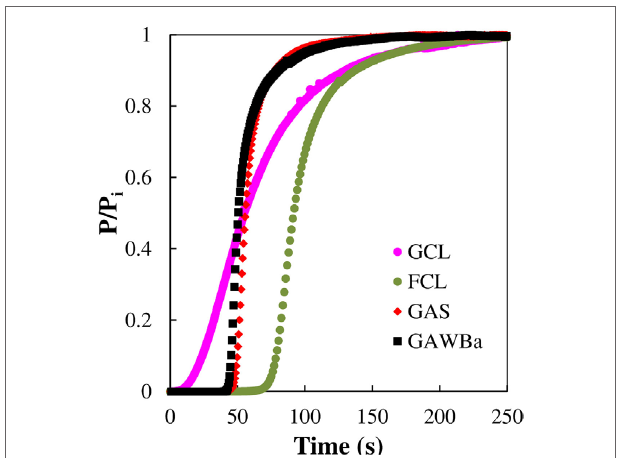
FigUre 9 | cycle of adsorption–desorption–adsorption of cO 2 at 25°c and 101.3 kPa (0.4 g of adsorbent, 50 cm 3 sTP/min, 15% cO 2 in n 2 ) over the activated carbon fiber Fcl